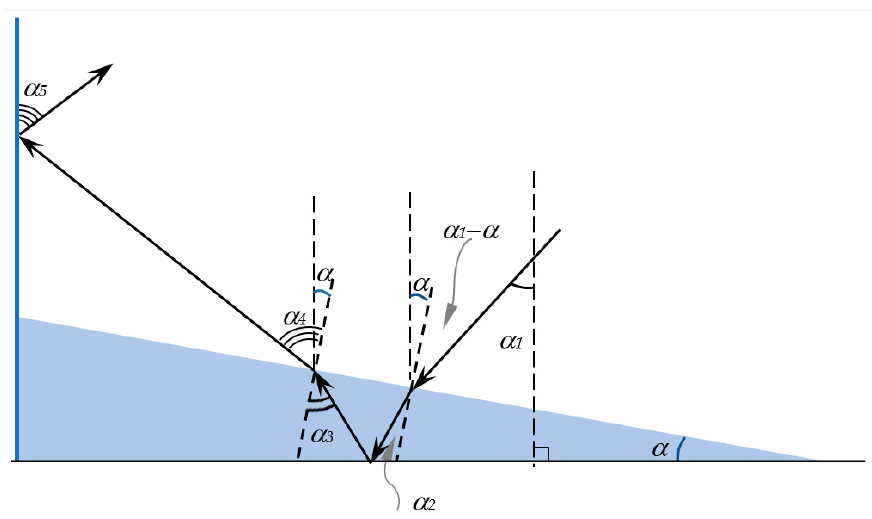
Figure 5. Signal propagation through the wedge-shaped snow layer within the dihedral.